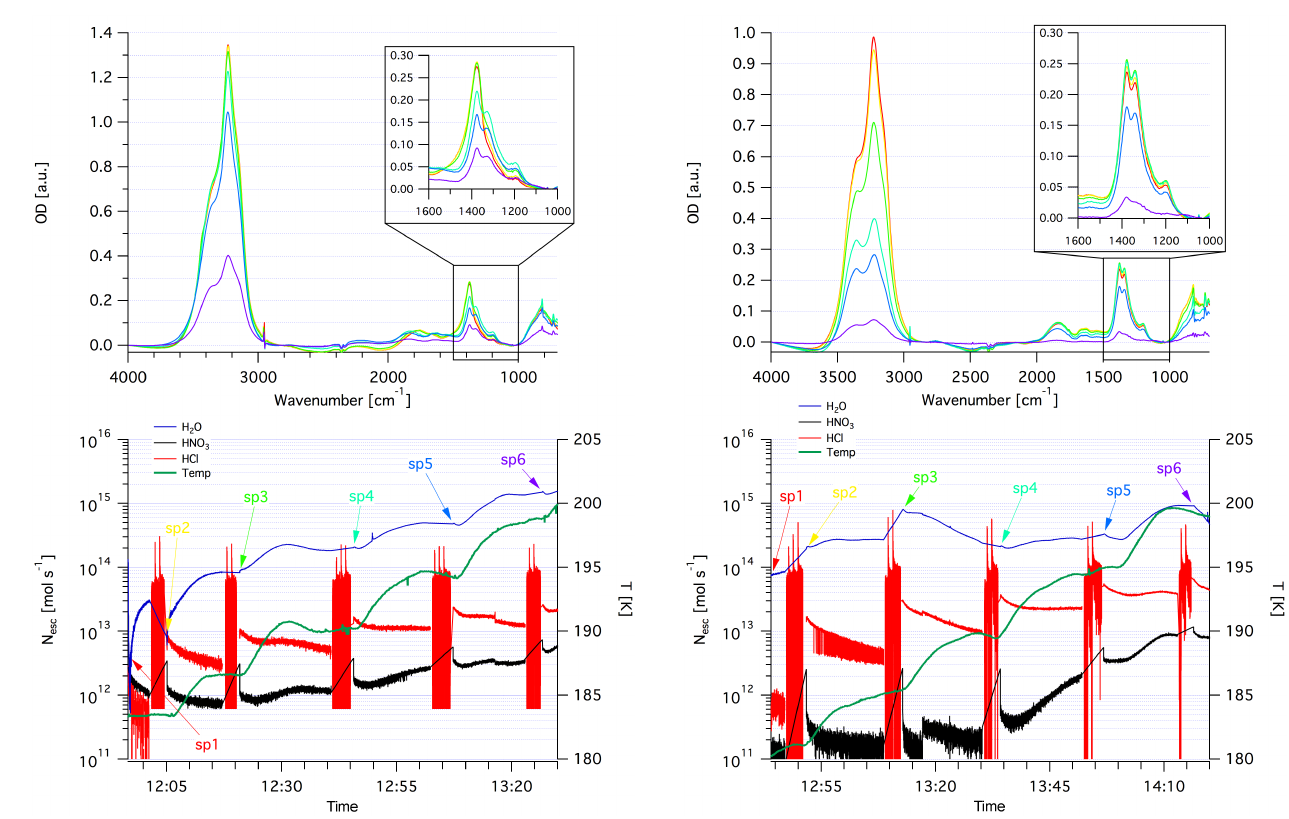
Figure 6. Repetitive PV (pulsed-valve) deposition experiment of HCl on an α -NAT/ice substrate under SFR conditions followed by MS (lower panel) and FTIR transmission across the thin film (up- per panel) as a function of time. In the lower panel the temperature is displayed as the green trace; the red MS signal represents HCl at m/e 36amu with the pulsed forcing recognizable as single peaks (12) on top of the red columns. The individual HCl doses corre- spond to approximately (4–5) × 10 16 molecule per pulse, resulting in a total dose of 3 × 10 17 molecules. The blue and black traces rep- resent the response of H 2 O ( m/e 18amu) and HNO 3 ( m/e 46amu) as a function of time (temperature) and HCl forcing. The upper trace displays FTIR transmission spectra at selected times indicated in the lower panel through color coding. The principal peak positions are listed in Table 3, and the changes are discussed in the text.